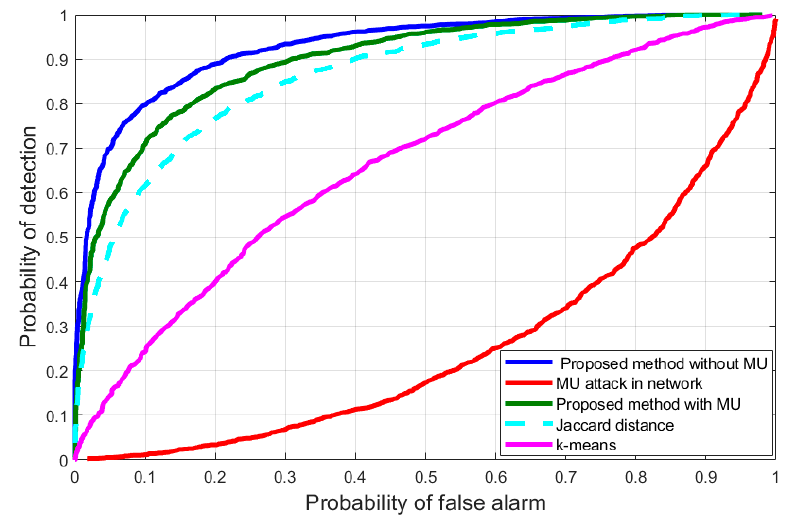
Figure 6. ROC curve of the proposed in comparison with other schemes.